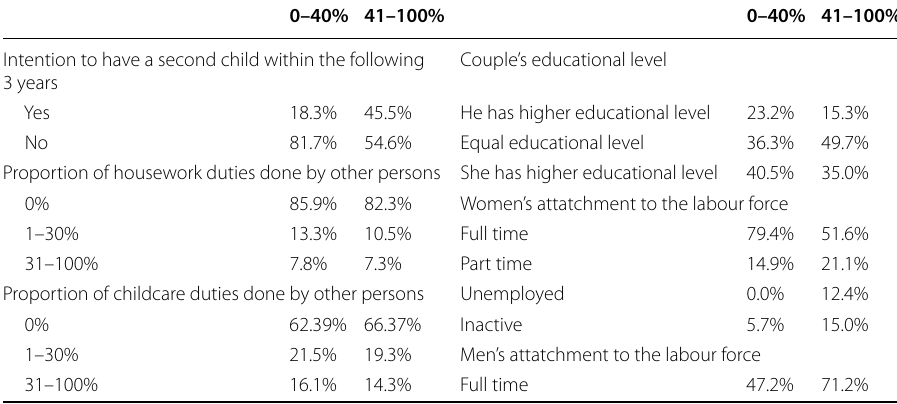
Table 7 Descriptive statistics of women experiencing favourable distributions of housework and the